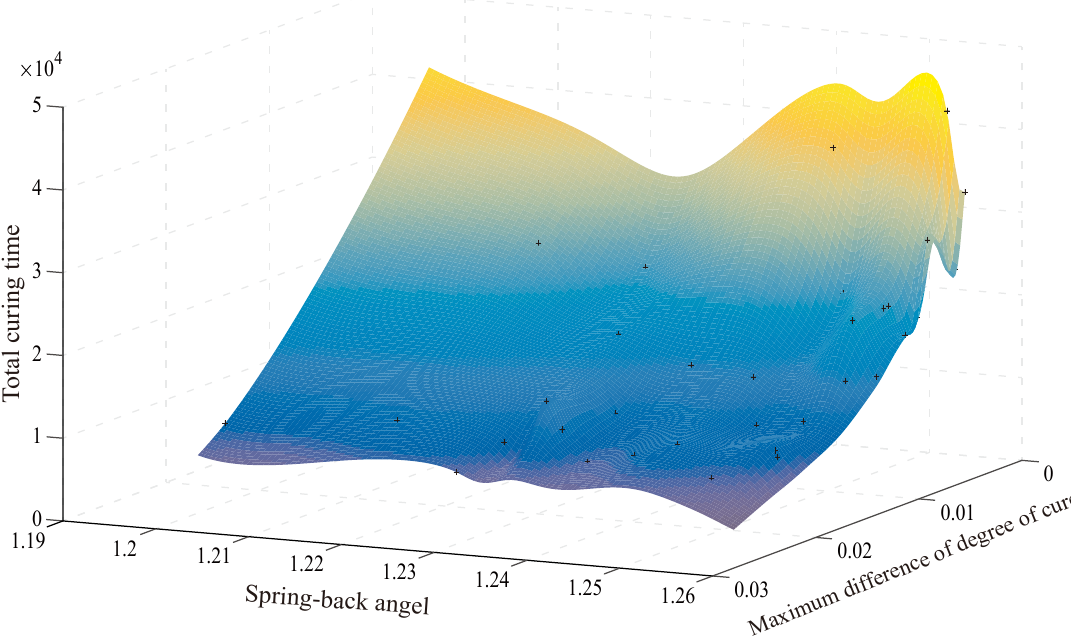
Figure 11. Surface plot of the Pareto front of the multi-objective optimization result. The optimized curing profile selected from Pareto front are reported in Table